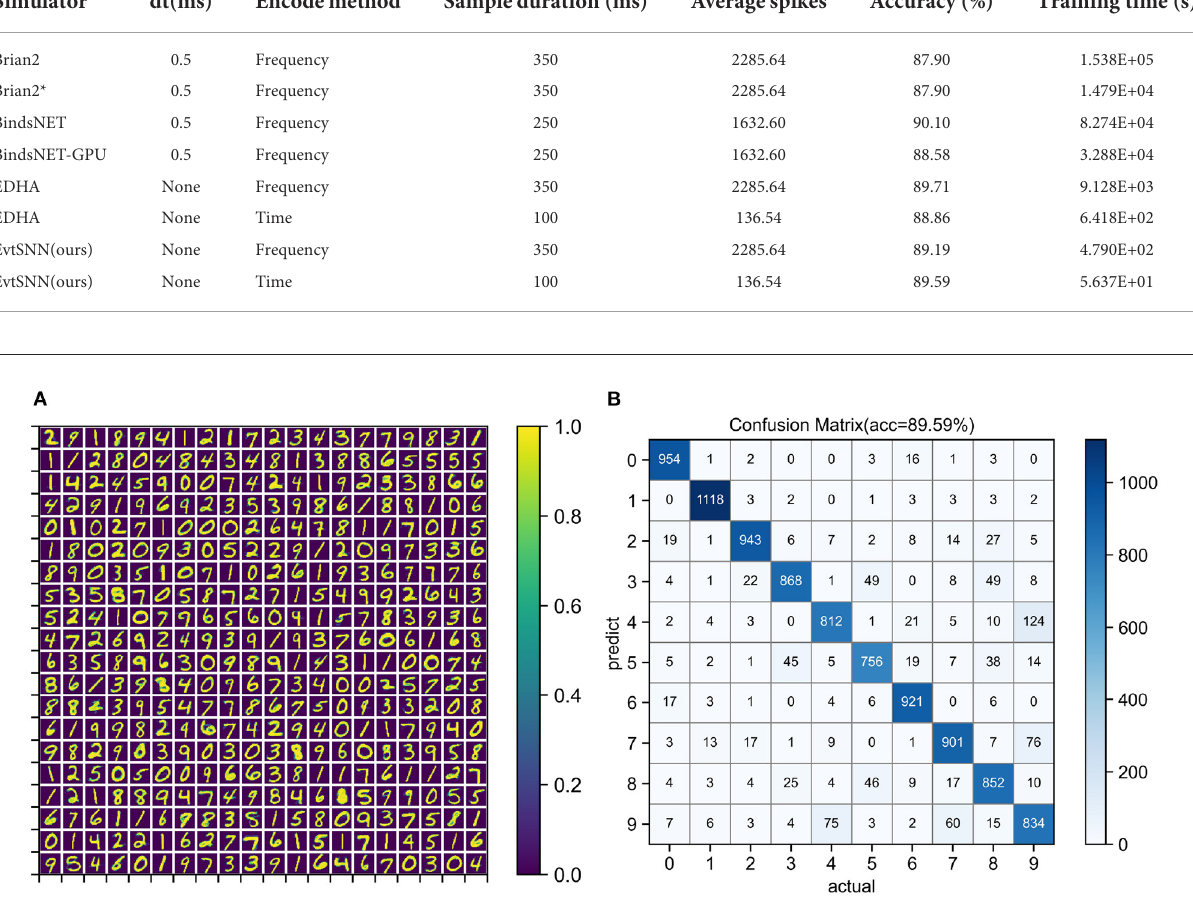
FIGURE7 (A) Weight visualization after 1 epoch of unsupervised learning on the MNIST training set. (B) Confusion matrix for classification on the MNIST test set. The network size used for training and testing is